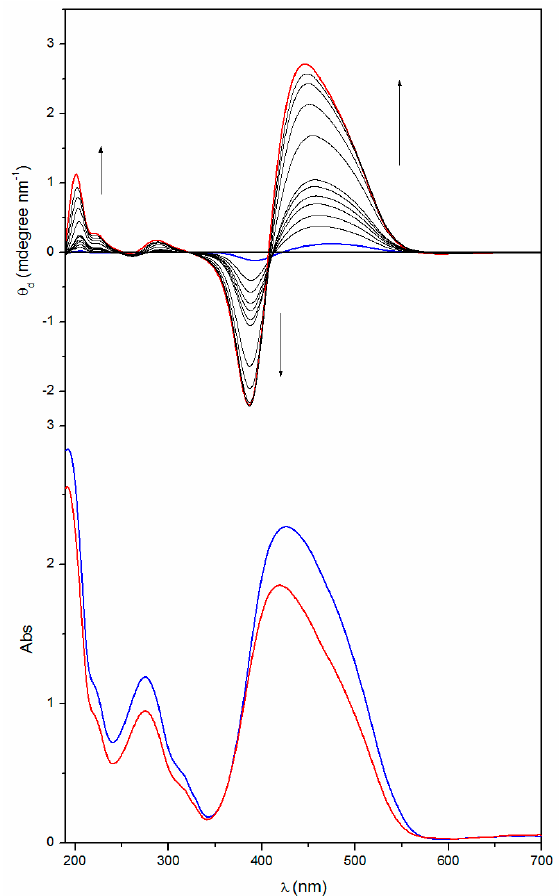
Figure 3. CD (up) and UV-Vis (bottom) spectra of a 270 nm thick film of poly[( S )- MAP-C ] before (—) and after annealing at 200 ◦ C for 5, 10, 15, 20, 25, 30, 40, 50, 60, 75 (—) and 100 (—) min. CD spectra are normalized for the film thickness.